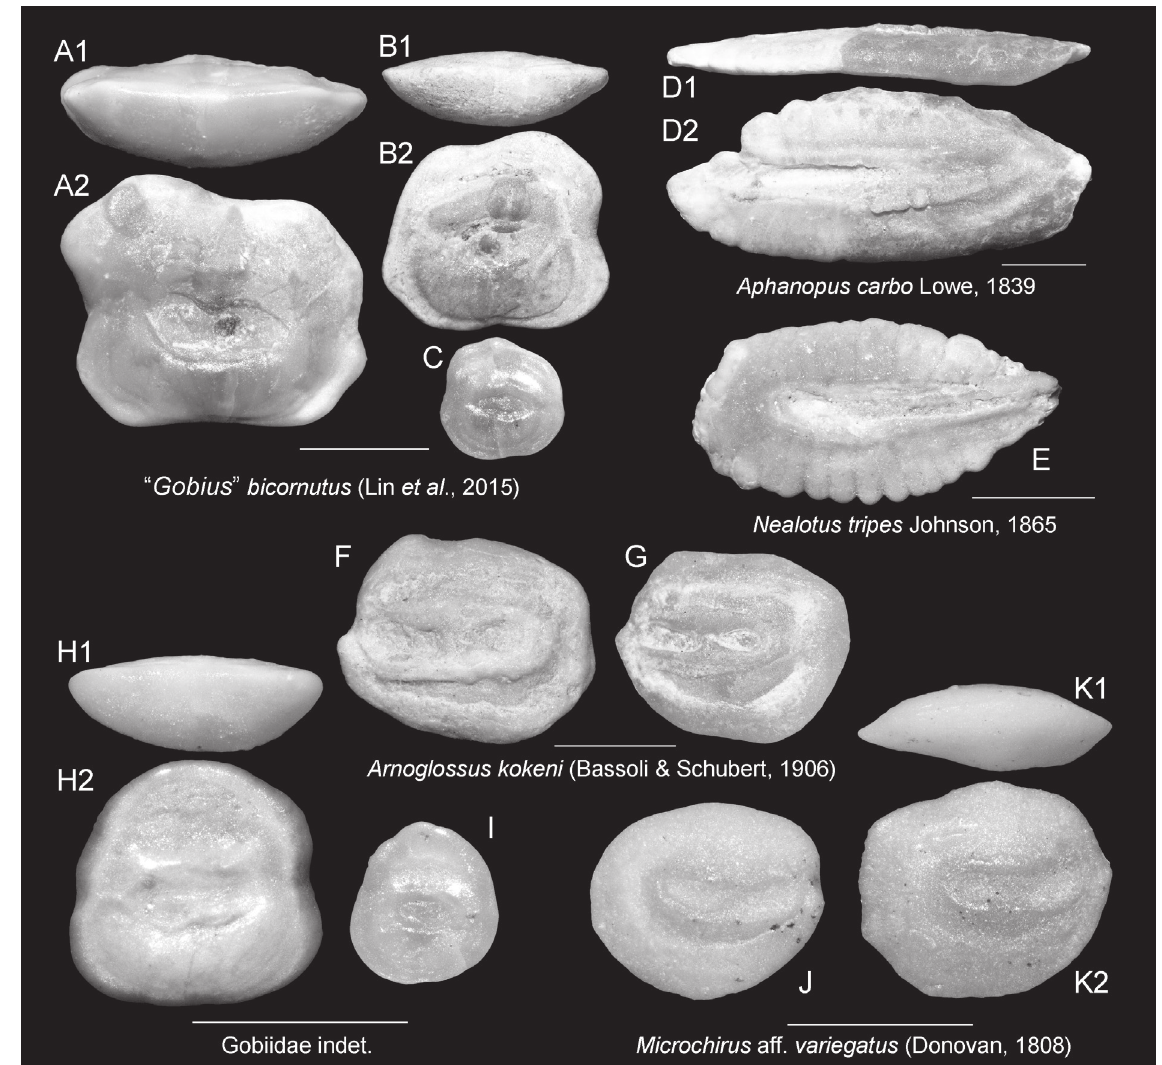
Fig. 12. Tortonian fish otoliths from northern Italy. A–C . “ Gobius ” bicornutus (Lin, Girone &